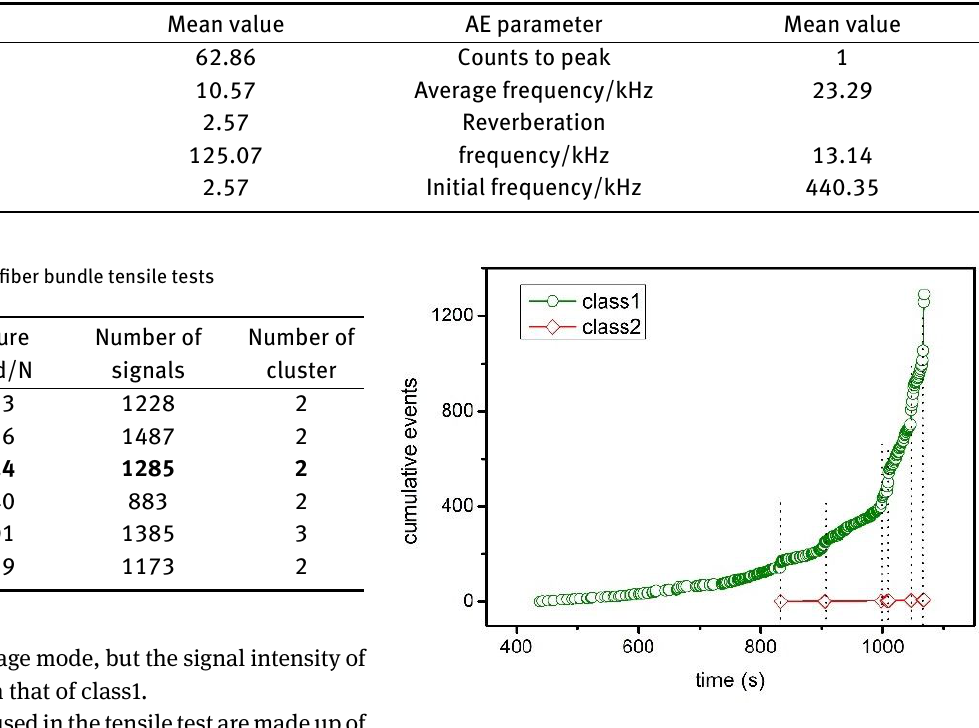
Figure 11: Cumulative events of AE signals for each cluster for fiber bundle tensile test